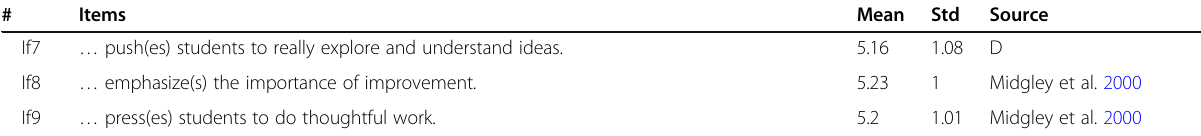
Table 2 Original set of Social Supports for Active Learning Instrument (SSAL) items. The prompt was: “ Please consider your experiences with your learning assistant(s), LAs, in the lecture portion of your General Chemistry 1 course and answer how much you agree with the statements below. ” Each item started with “ The learning assistant(s) …” Mean values and standard deviations from general chemistry students given. Original source for each item is indicated in the last column. D, developed for this